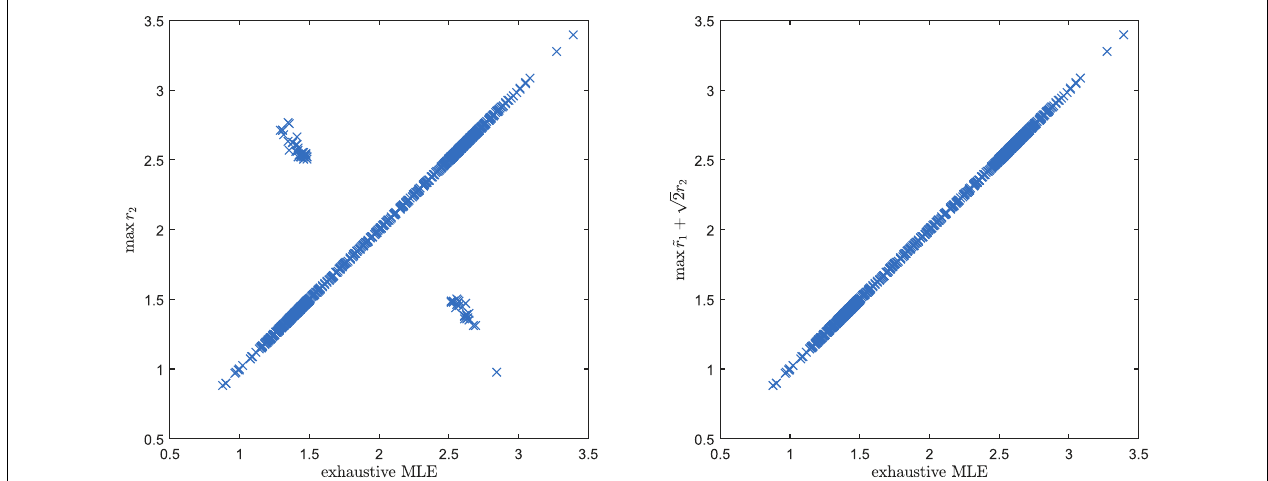
FIGURE 7 | Comparison between decoding maximizing r 2 (Forssén, 2004), left, and the proposed MLE according to Theorem 2.4, right . 1000 random measurements have been generated with random weights and encoded with 7 channels.